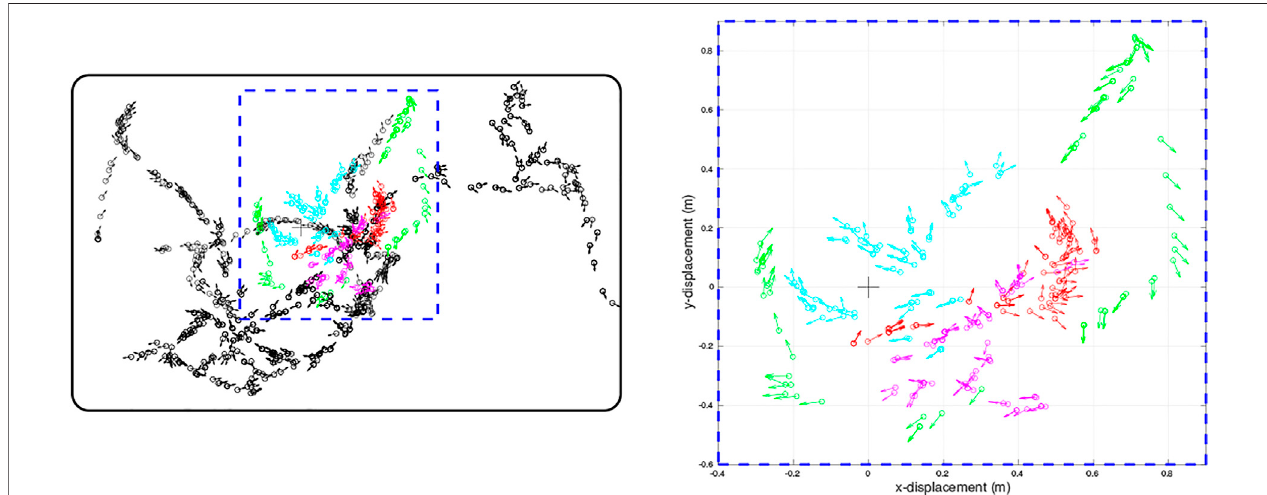
FIGURE 2 | Quiver plots ofthe poses ofWhiskEye ’ shead(de fi ned as x,y position and head direction)at each sample point taken for the training set (black) and for each of the test sets (red, cyan, magenta, green) used to evaluate the models. Each test set was recorded from a different initial pose of WhiskEye and in the arena populated with different object con fi gurations to test for generalisation. The right panel is a scaled view of the region indicated by the blue dashed rectangle in the left panel. The bold black rectangle enclosing the sample points in the left panel indicates the boundary walls of the arena. The arena measured 3.5 m by 2.25 m